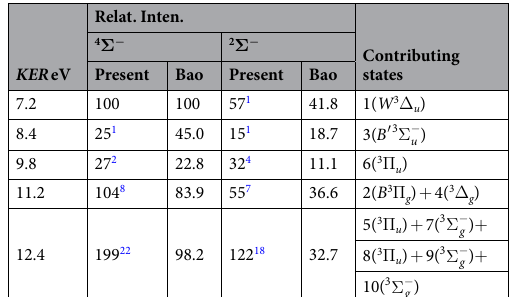
Relat. Inten. 4 Σ −